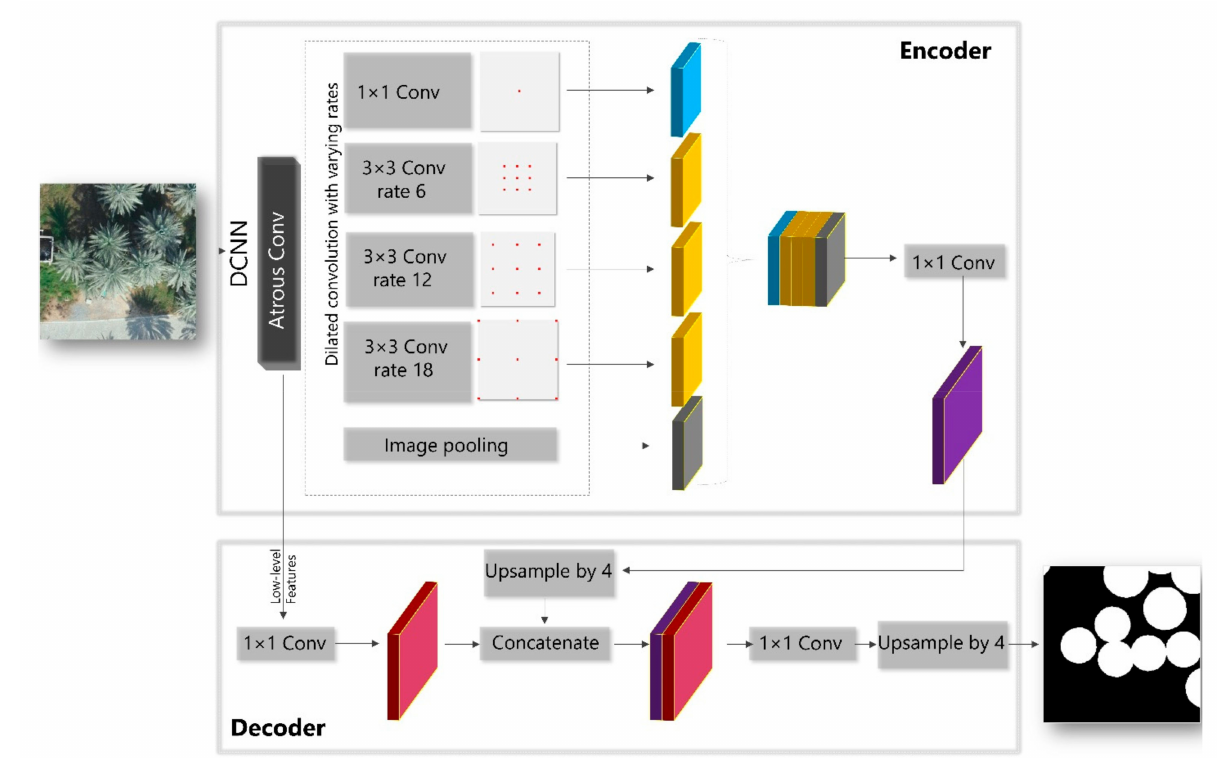
Figure 4. DeepLab V3+